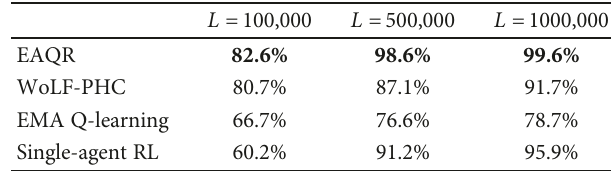
Table 2: Average success rate for 4-agent/12-vertex box-pushing (evaluation episodes =50,000).